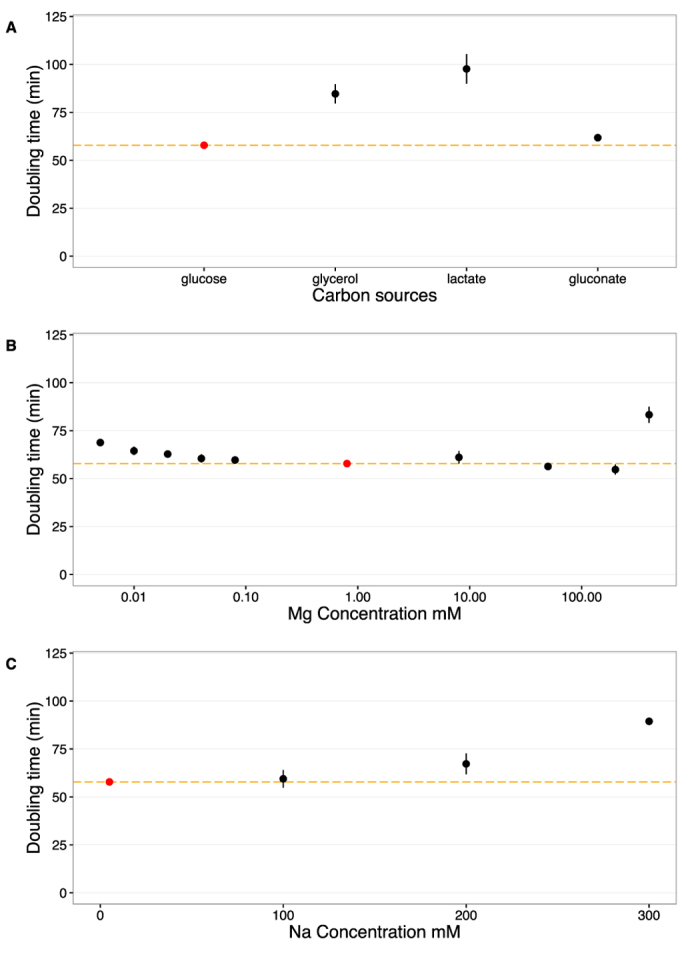
Doubling times under various growth conditions.We measured doubling times under exponential phase for all growth conditions. The red points and dashed orange lines represent the doubling time at the base condition (glucose, 5 mM Na+, 0.8 mM Mg2+). Doubling times were measured in triplicates and error bars represents 95% confidence intervals of the mean. (A) Doubling times with respect to carbon sources. (B) Doubling times with respect to Mg2+ concentrations. (C) Doubling times with respect to Na+ concentrations.